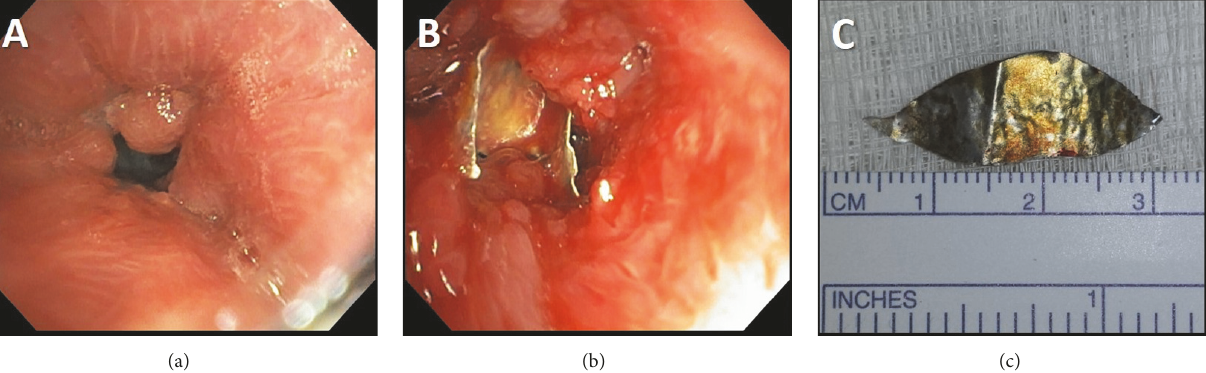
Figure 2: (a) Left mainstem bronchus with near-occlusion from obstructing granulation tissue. (b) Metallic foreign body appreciated in the distal left mainstem bronchus. (c) Metallic foreign body after